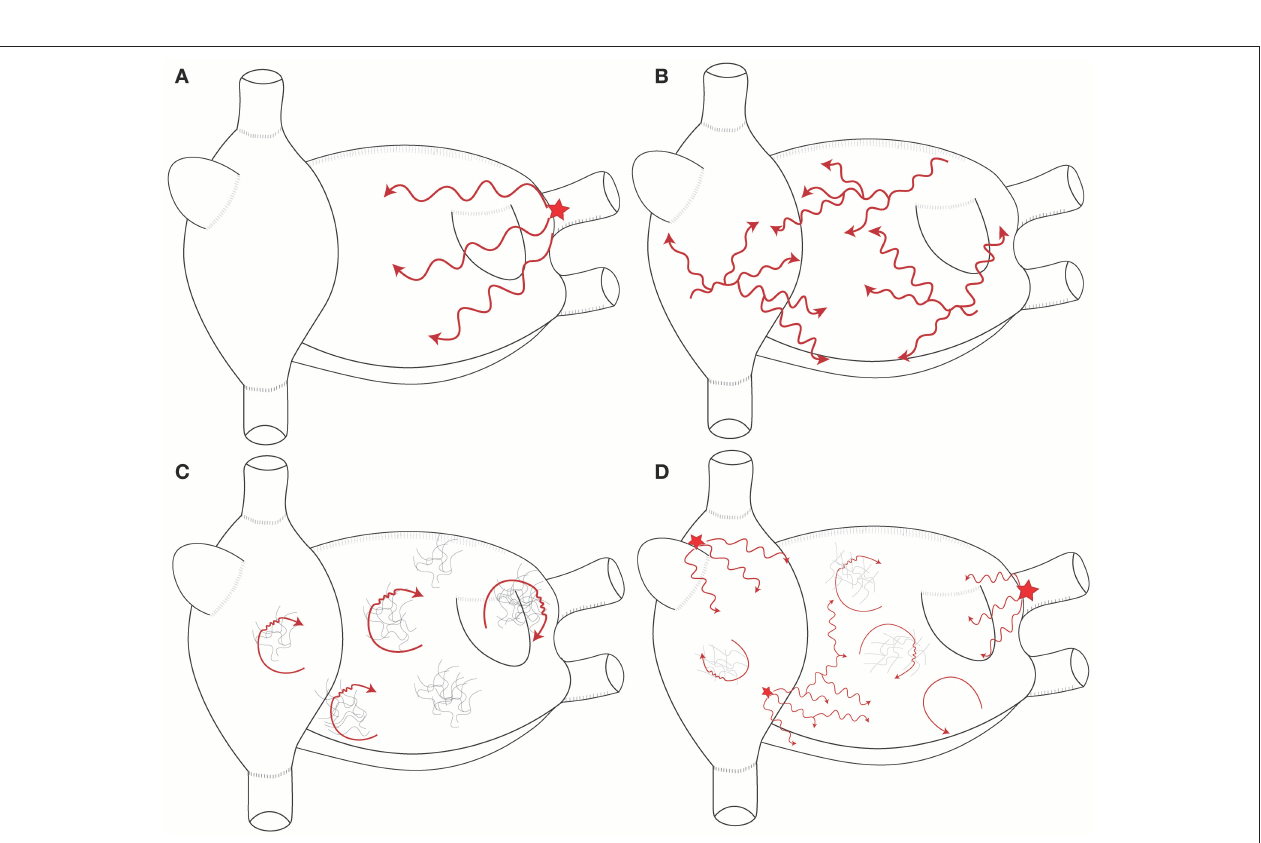
FIGURE 2 | Schematic representation of the mechanisms maintaining AF. (A) Single stable focal or reentrant source (star) with fibrillatory conduction. (B) Multiple wavelets: multiple waves propagate randomly and give birth to new daughter wavelets. (C) Multiple reentries (red arrows) around areas of scar and fibrosis. (D) Combination of the different mechanisms that sustain AF in humans. These mechanisms are typically meandering and last for few consecutive beats.